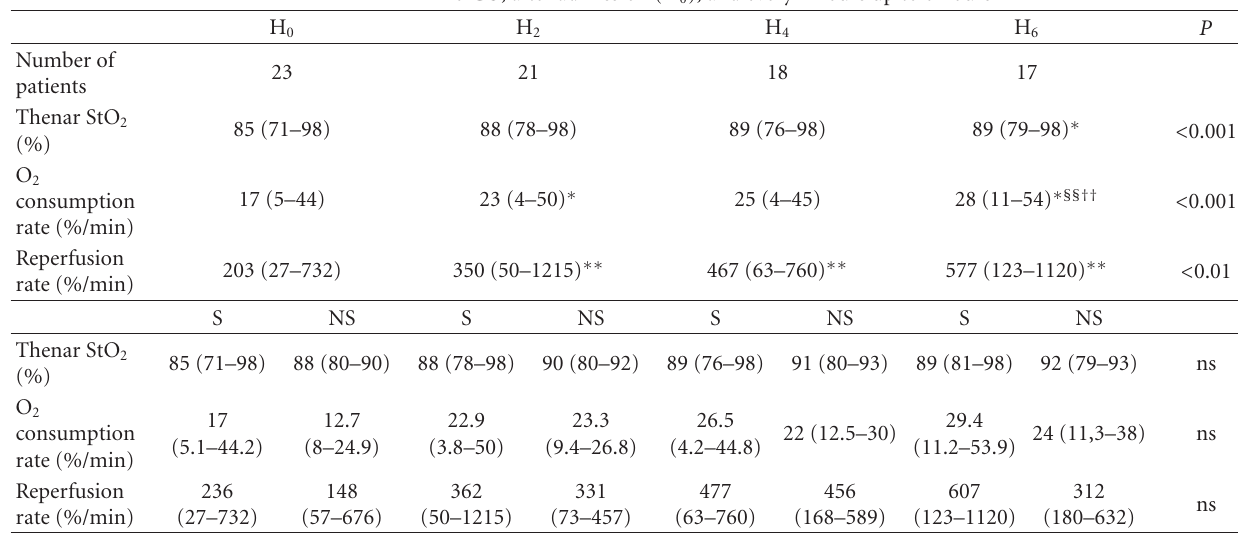
Table 2: (a) Microcirculation parameters assessed after cICU admission (H0) and every 2 hours for 6 hours (H2, H4, H6) in survivors and nonsurvivors combined. Data are presented as median (range). Microcirculation parameters assessed after cICU admission (H0) and every 2 hours for 6 hours (H2, H4, H6) in survivors (S) and nonsurvivors (NS). Data are presented as median (range). (b) Global Hemodynamics, pressure, lactate concentration, and temperature parameters assessed after cICU admission (H0) and every 2 hours for 6 hours (H2, H4, H6) in survivors and nonsurvivors combined. Data are presented as median (range). Global Hemodynamics, pressure, lactate concentration, and temperature parameters assessed after cICU admission (H0) and every 2 hours for 6 hours (H 2 , H 4 , H 6 ) in survivors (S) and nonsurvivors (NS). Data are presented as median